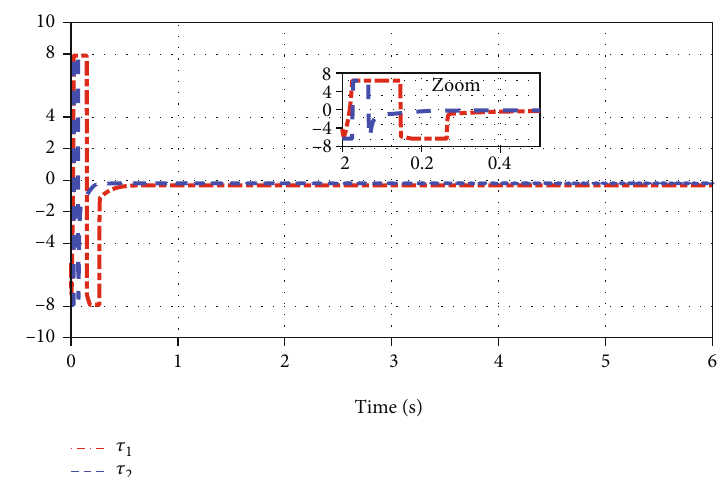
and b σ responses with Case 1. 1 2